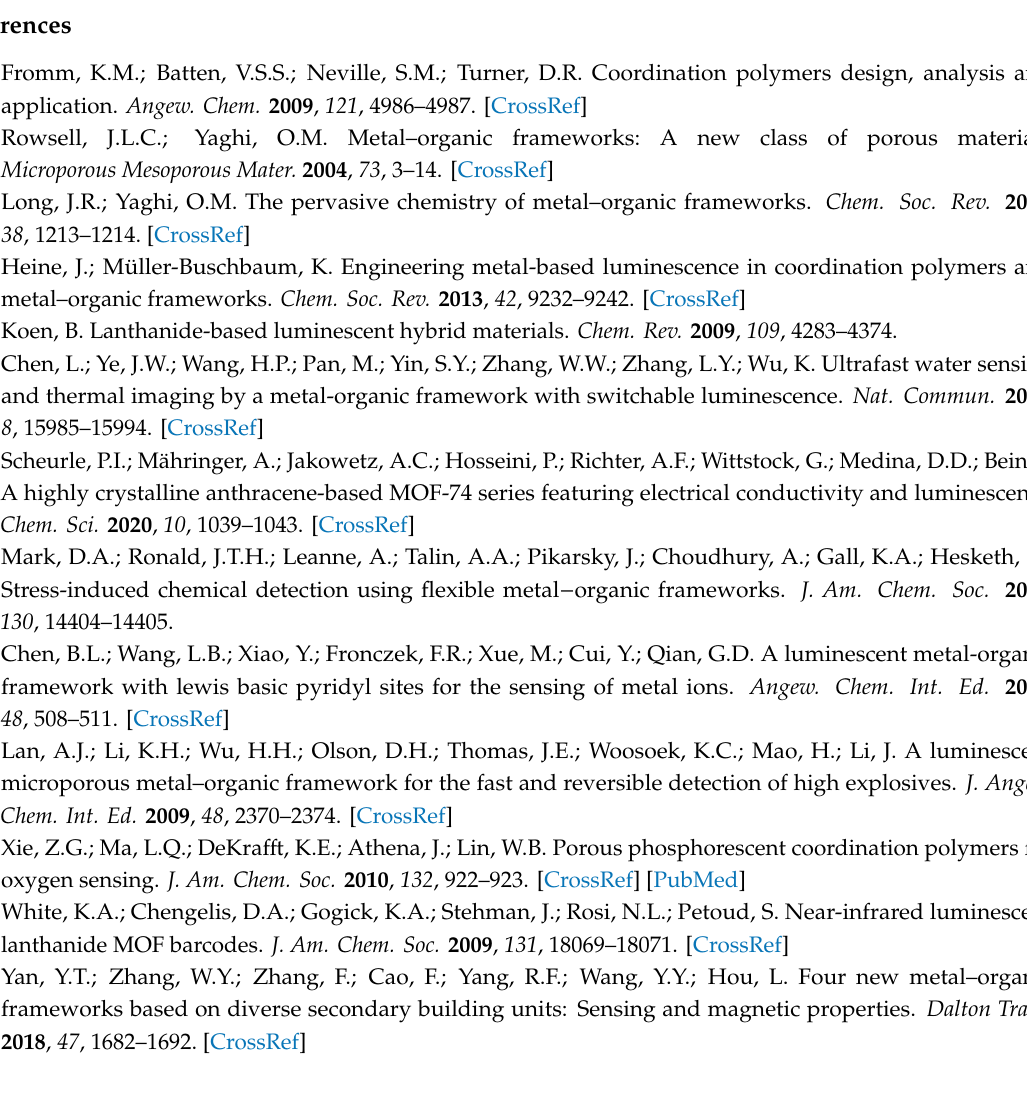
The thermal analysis of the complex; Figure S4: PXRD patterns of the complex: the simulated pattern from single crystal; Figure S5: PXRD patterns of the complex (for immersion experiment): the red is before and the black is after; Figure S6: Emission spectrum of the complex at di ff erent metal ions in deionized water; Figure S7: The UV-vis absorption spectra of metal cations aqueous solution with the same concentration of analytes (10 − 2 M) and the excitation spectra of the complex; Figure S8: (a) XPS spectra of the 1@Fe (red) and original 1 (black); (b) O1s XPS spectra of the original 1 (black) and 1@Fe 3 + (red); Figure S9: Emission spectra of the complex at di ff erent solvents concentrations in deionized; Figure S10: PXRD patterns of the complex: the red is DMK and the black is the complex. Table S1: Crystal data and structure refinement for the complex; Table S2: Selected bond lengths (Å) and bond angles ( ◦ ) for the complex; Table S3: Hydrogen bond length (Å) and bond angle ( ◦ ) for the complex; Table S4: The LOD compared to previously reported complexes; Table S5: Selected atom net charges and electronic configuration of the complex at the B3LYP / (6-31 + G(d) (for C, H, N and O) and Lanl2dz (for Zn)